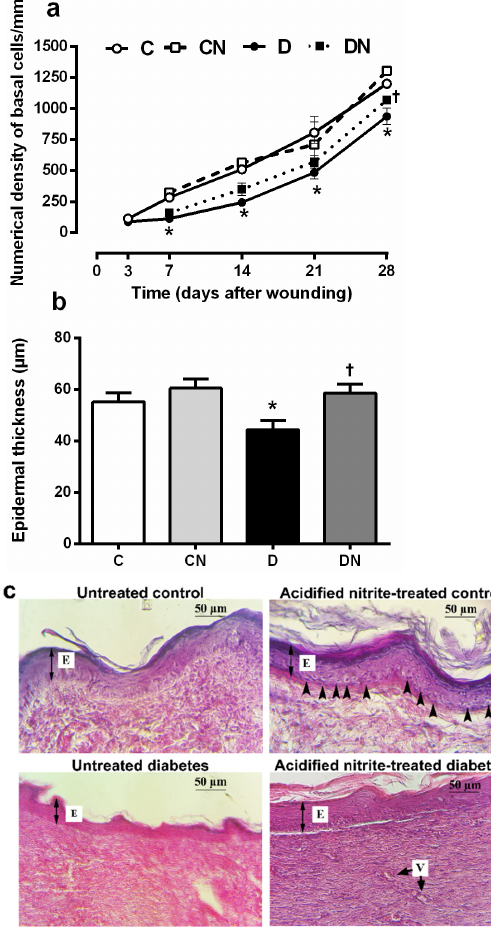
Figure 2. Effect of the topical application of acidified nitrite on the basal cell numerical density during wound healing ( a ) and epidermal thickness at day 28 after wounding ( b ). Representative images of hematoxylin and eosin (H&E)-stained sections at day 28 after wounding (400× magnifi- cation and scale bar = 50 μ m) ( c ). E, Epidermis; V, microvessels; ▲ , basal cells; C, untreated con- trol; CN, acidified nitrite-treated control; D, untreated diabetes; and DN, acidified nitrite-treated diabetes. * p < 0.05 compared to untreated control rats, and † p < 0.05 compared to untreated dia- betic rats. Values are mean ± SEM, n = 6/subgroup.